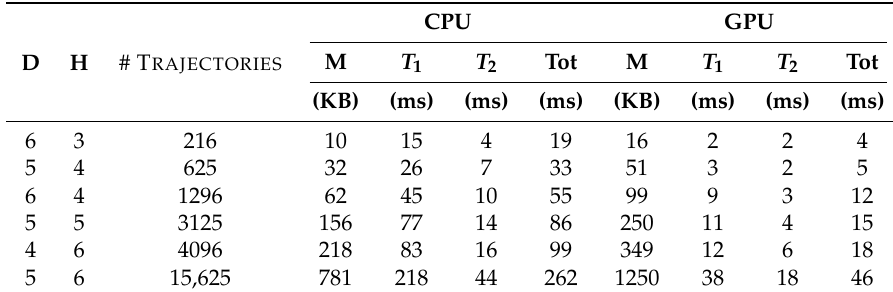
Table 1. Comparing CPU and GPU wall-clock or elapsed times for several real-world scenarios. All times are reported in